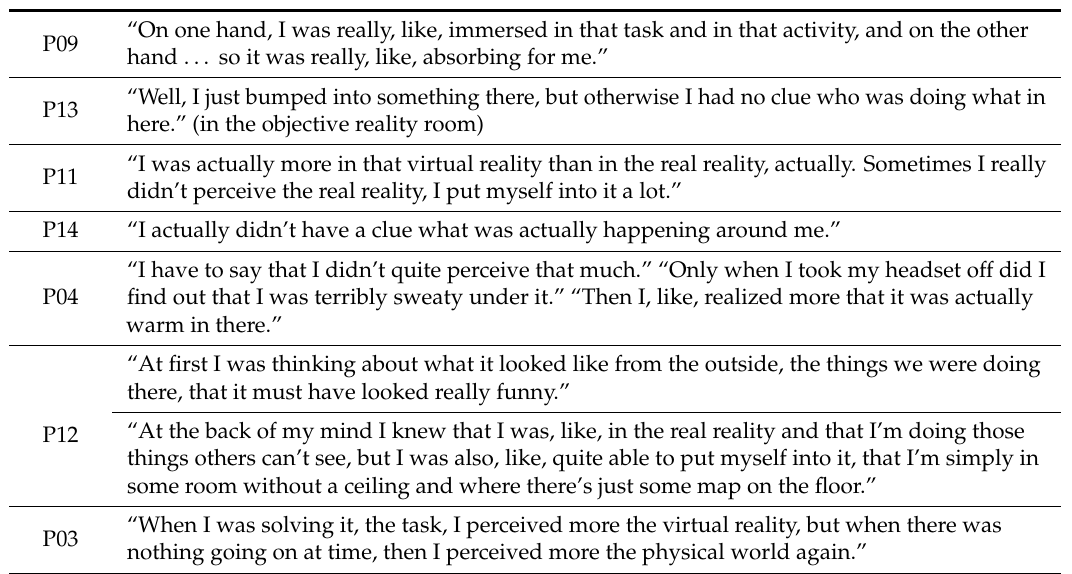
Table 9. Verbatim excerpts of statements by participants: Immersion and involvement in the artificial